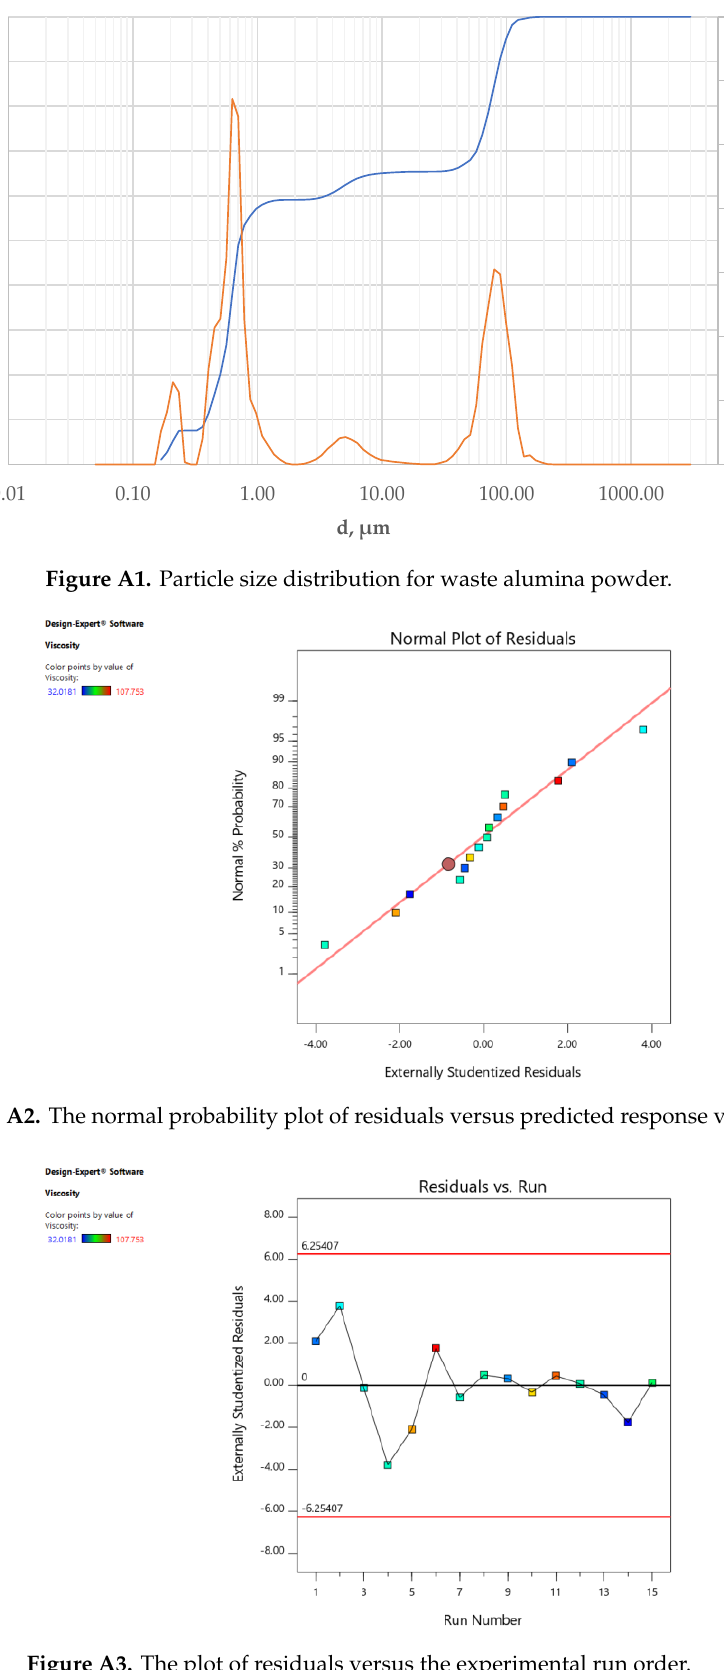
Figure A3. The plot of residuals versus the experimental run order. Table A2. Measured apparent viscosity of all prepared suspensions.